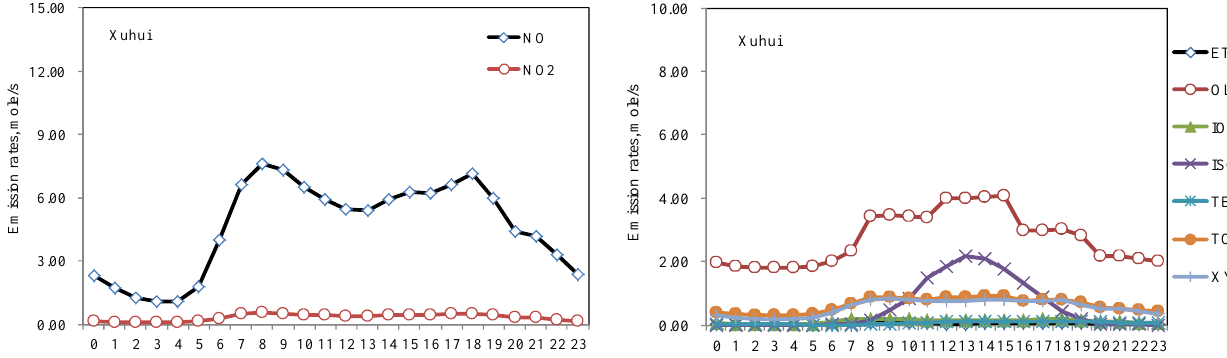
Fig. 9. Emission inputs of NO x and main VOC species at Xuhui site. Fig.9. Emission inputs of NO and main VOC species at Xuhui site x Table 1. Statistical results between MM5 model and observation data at surface stations in